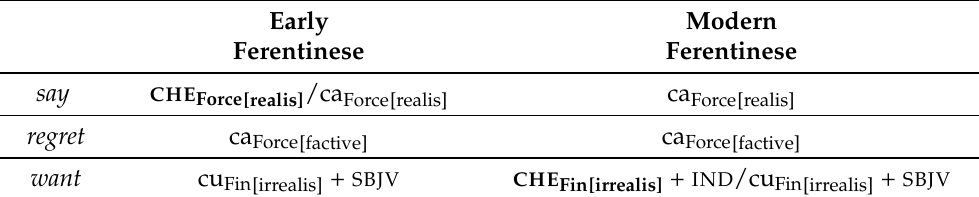
Table 2. Complementizer distribution in Early and Modern